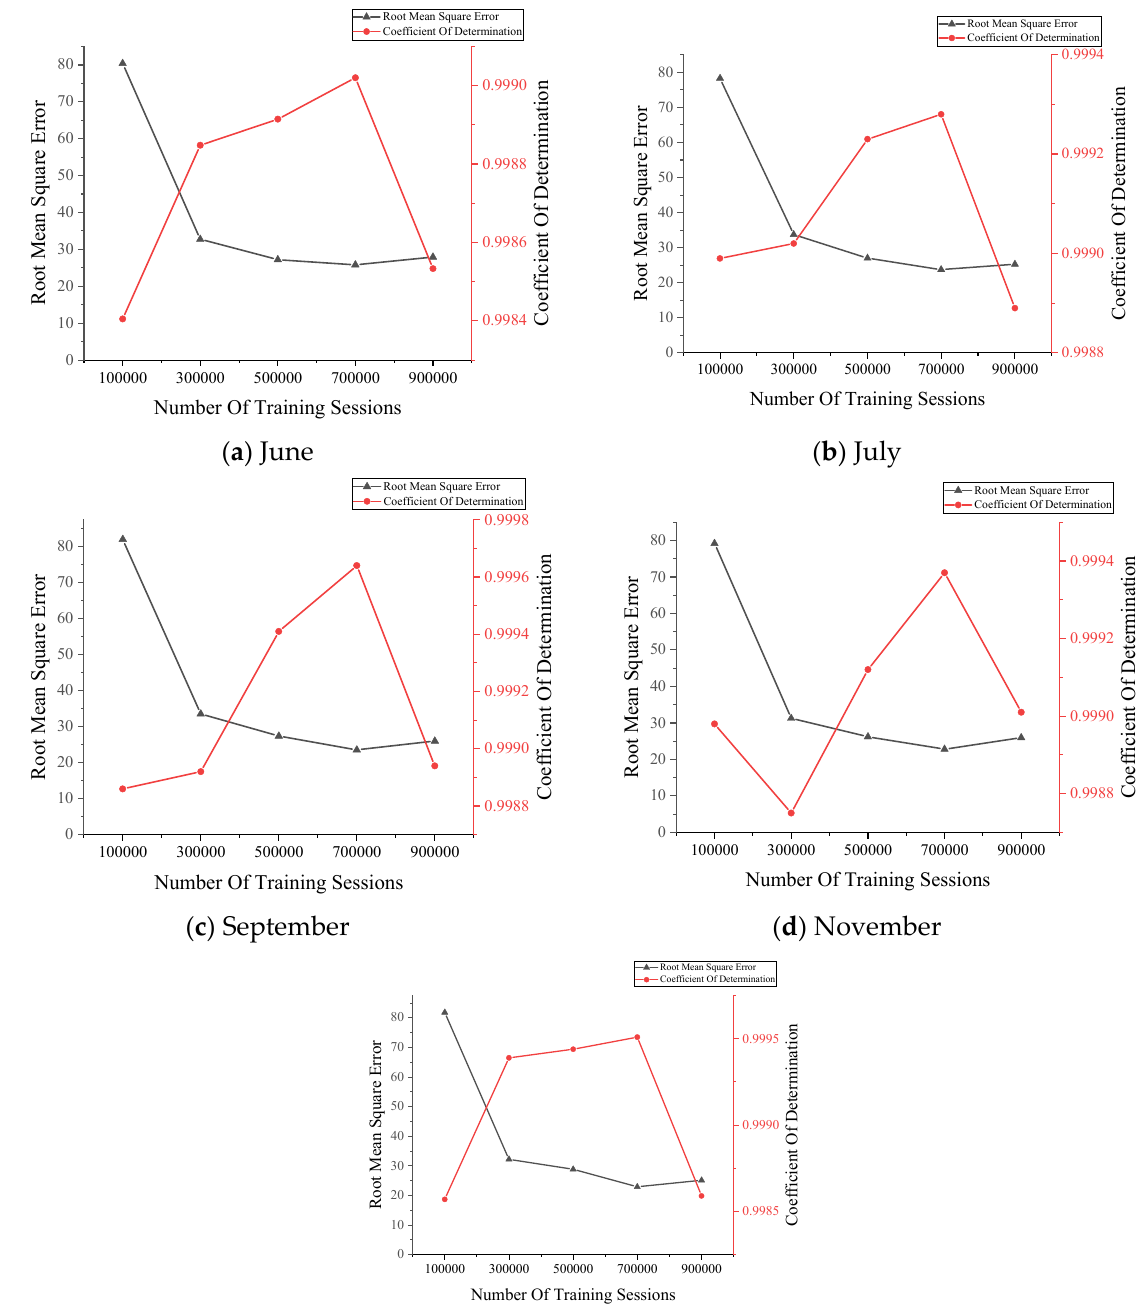
Figure 5. The data reconstruction results.